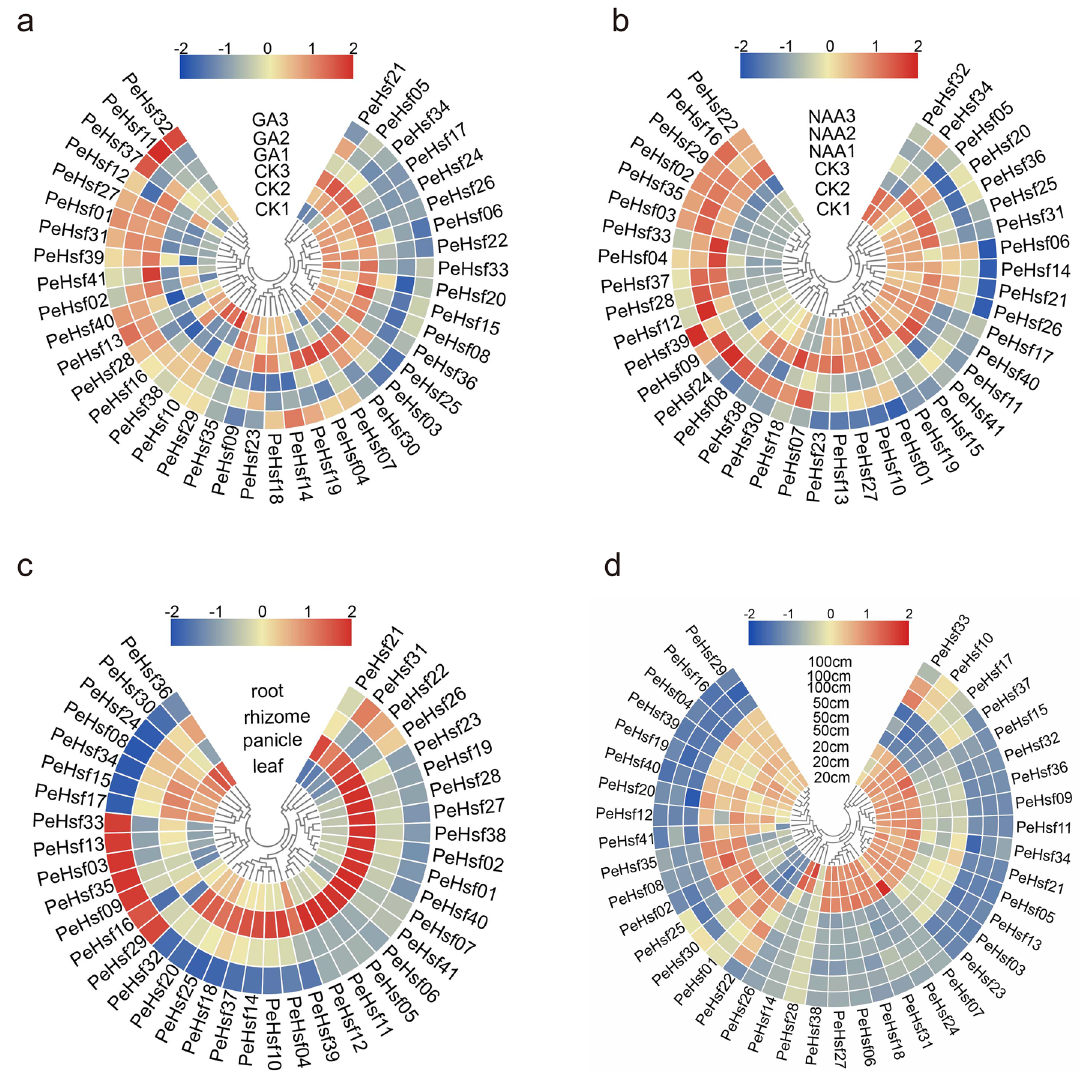
Figure 10. Heat maps of PeHsf gene expression (log 10 -transformed TPM values) in multiple tissues and in response to hormone treatments. ( a ) GA treatment. ( b ) NAA treatment. ( c ) Roots, rhizomes, panicles, and leaves. ( d ) Young bamboo shoots of different heights. CK, control group. Each tissue or treatment was replicated three times and its gene expression levels averaged. The relative expression levels are depicted according to the color scale, where a change from blue to red indicates transcript abundance from low to high. Amazing Heatmap in TBtools (v1.0697) is used to generate expression